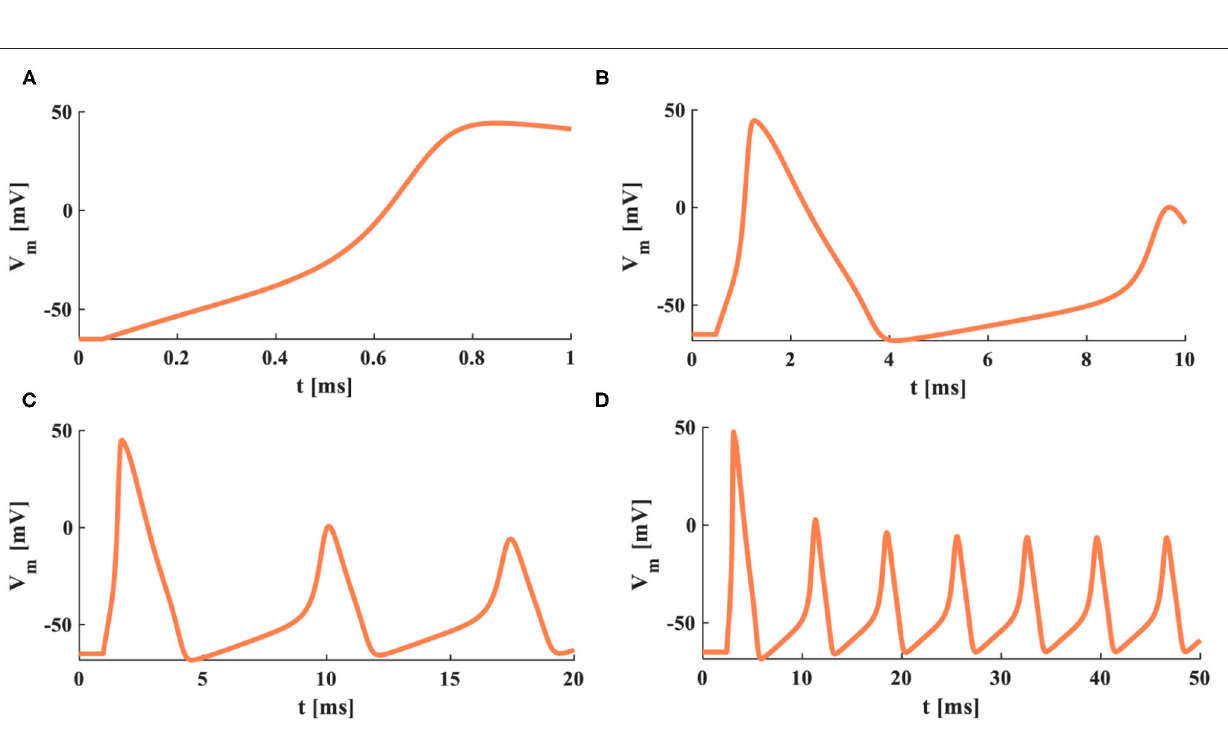
Frontiers in Neuroscience |